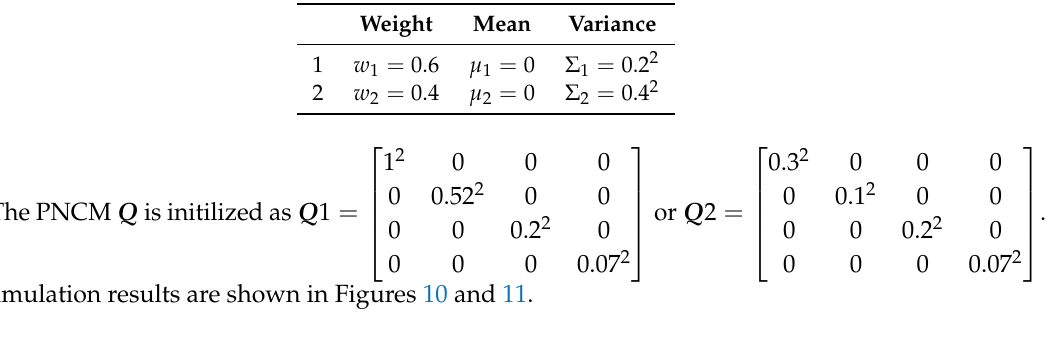
Table 5. The parameters of GMD.